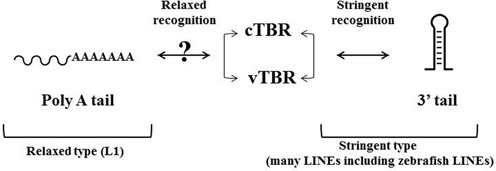
A schema of evolutionary processes by which two types of LINEs have been established via interactions between ORF2 and 3′ tail RNA. An arrow with two arrowheads indicates the interaction of concerted evolution to generate one of two types of LINEs during evolution.